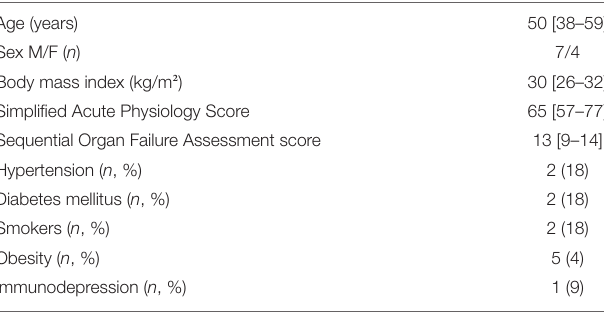
TABLE 1 | Baseline characteristics of patients.